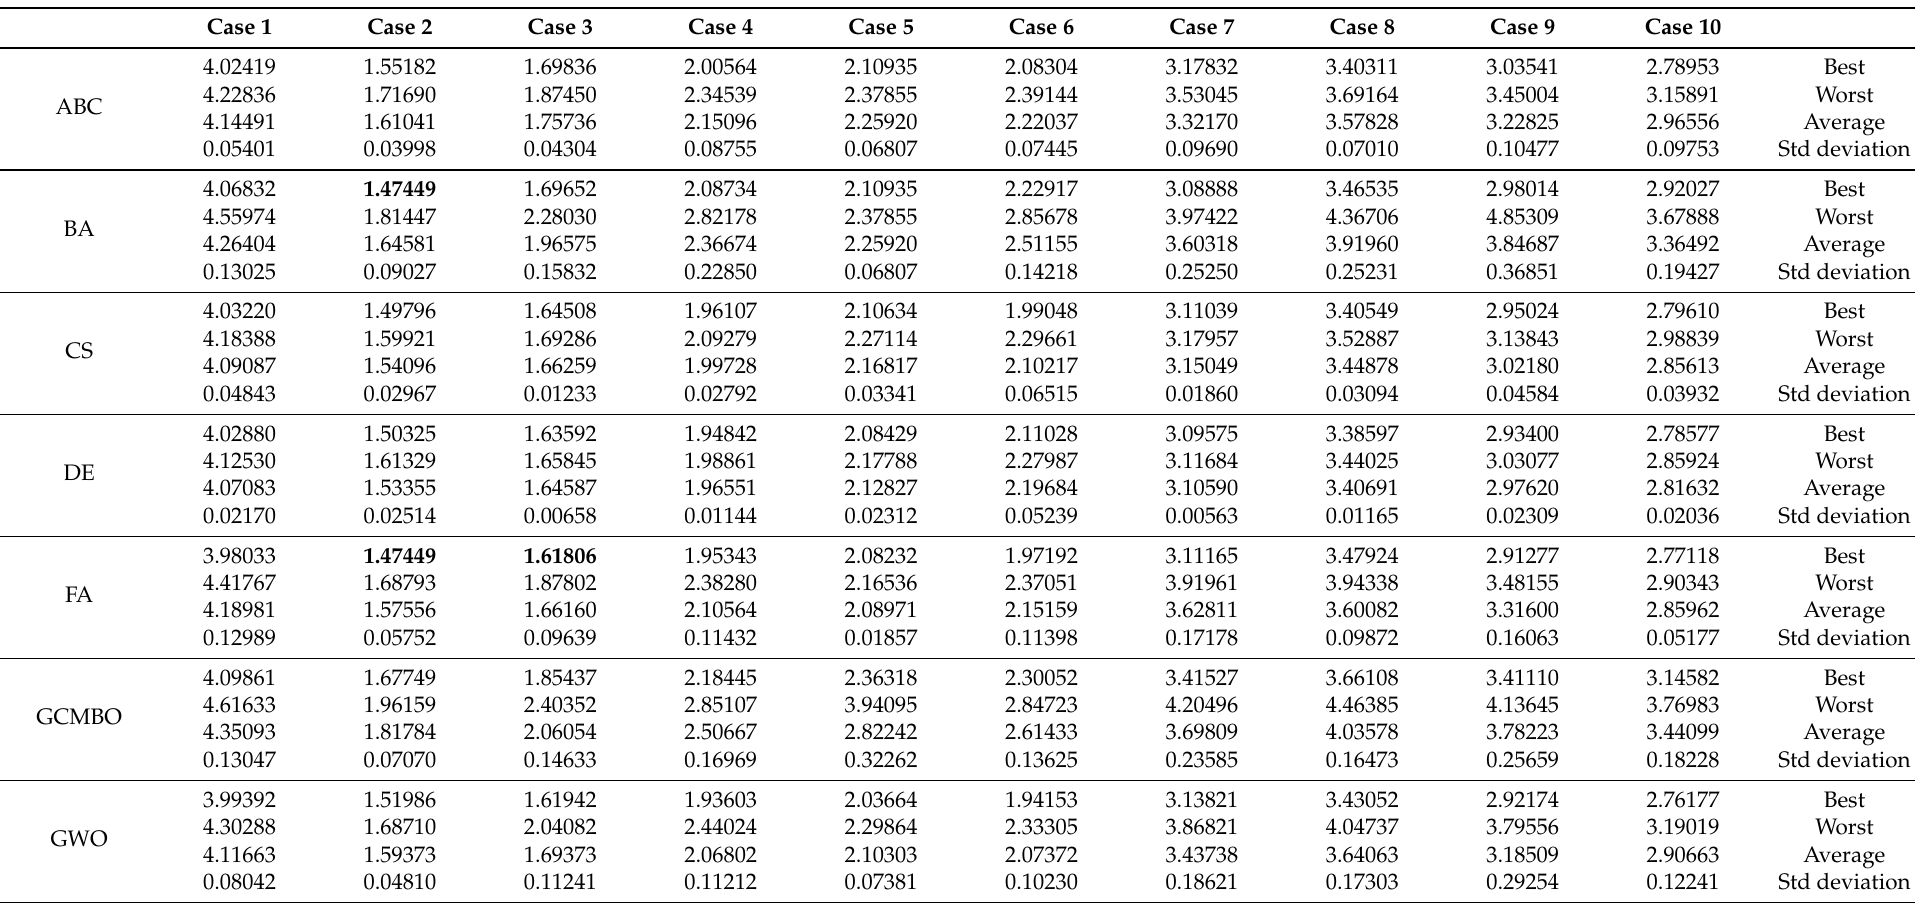
Table 2. Performance comparison of different swarm intelligence algorithms for small-scale uninhabited combat air vehicle (UCAV) path-planning. The best, worst, average and standard deviation over 25 runs of each algorithm for ten cases are provided. The best values are in